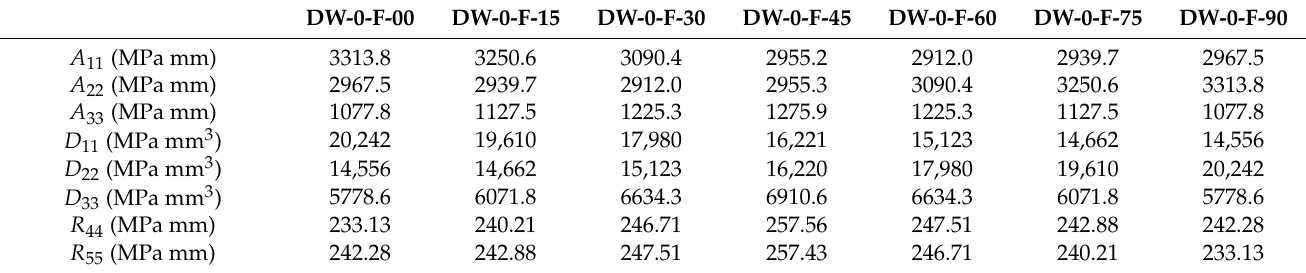
Table 7. Selected stiffnesses in DW samples with no perforation and with different flute